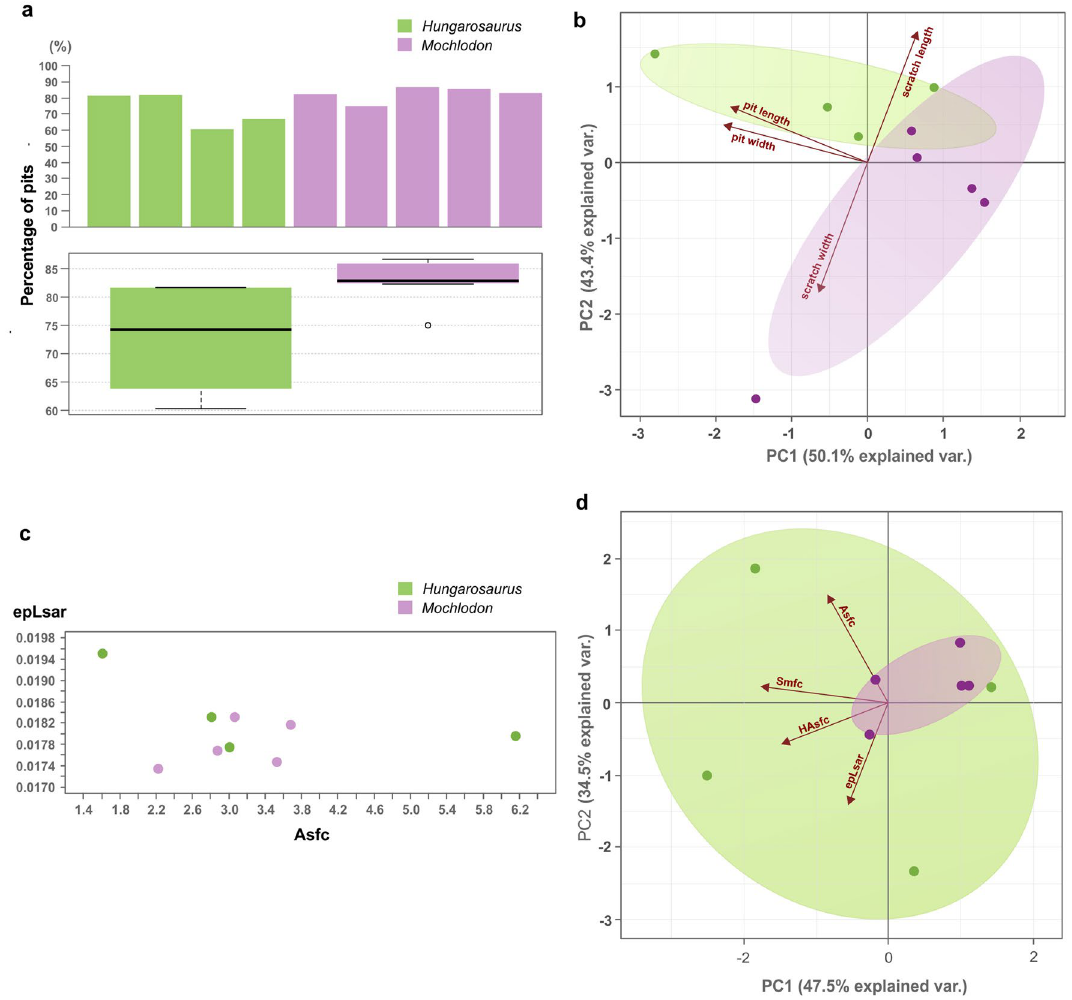
Figure 5. Results of the traditional (2D) microwear and DMTA. ( a ) Mean pit percentage based on four microgaphs taken from four teeth of Hungarosaurus tormai and five teeth of Mochlodon vorosi . ( b ) PCA analysis of traditional (2D) microwear data from Hungarosaurus tormai and Mochlodon vorosi using four microwear variables. Note the slightly larger pit dimensions in Hungarosaurus tormai . ( c ) Comparison of the DMTA data between Hungarosaurus tormai and Mochlodon vorosi . ( d ) PCA results of the DMTA analysis.